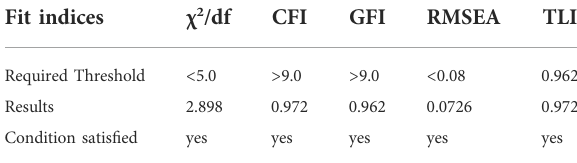
TABLE 2 Model evaluation —